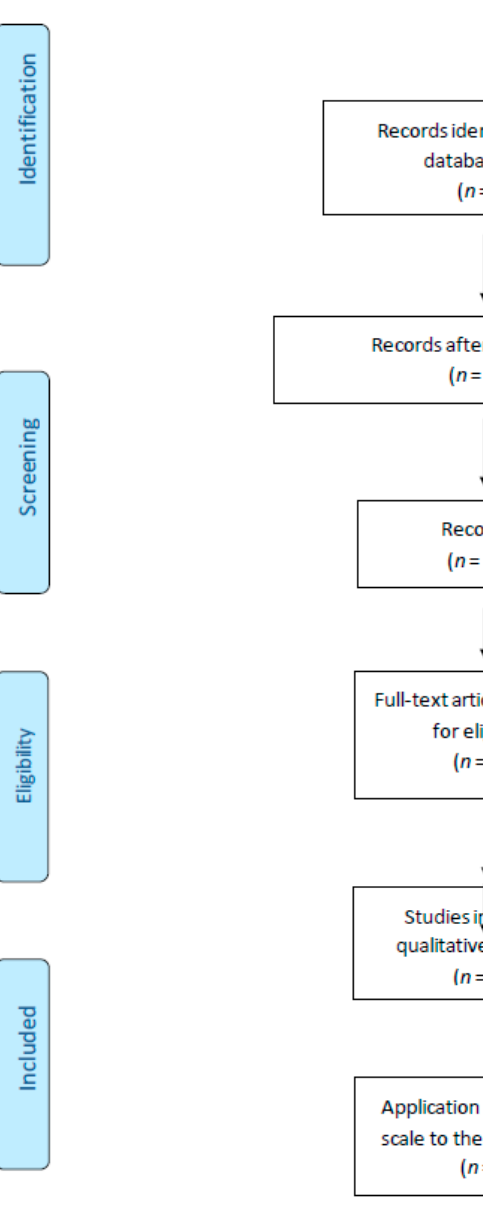
Table 2. Study characteristics and main results.